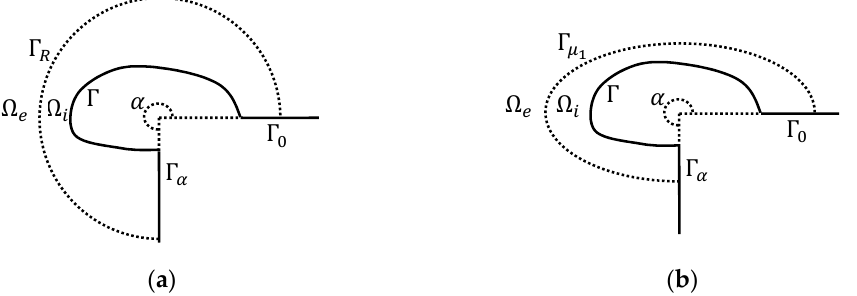
Figure 2. Two different artificial boundaries: ( a ) The circular arc artificial boundary Γ R ; ( b ) The elliptical arc artificial boundary Γ µ 1